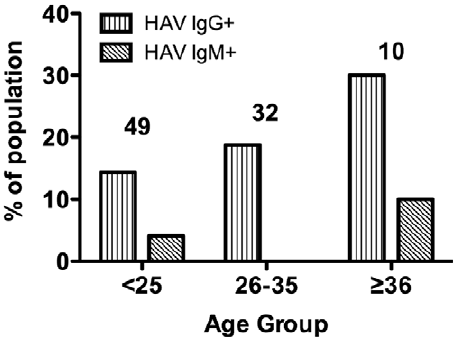
Figure 1. Distribution of anti-HAV IgG and IgM in blood donors according to age group.